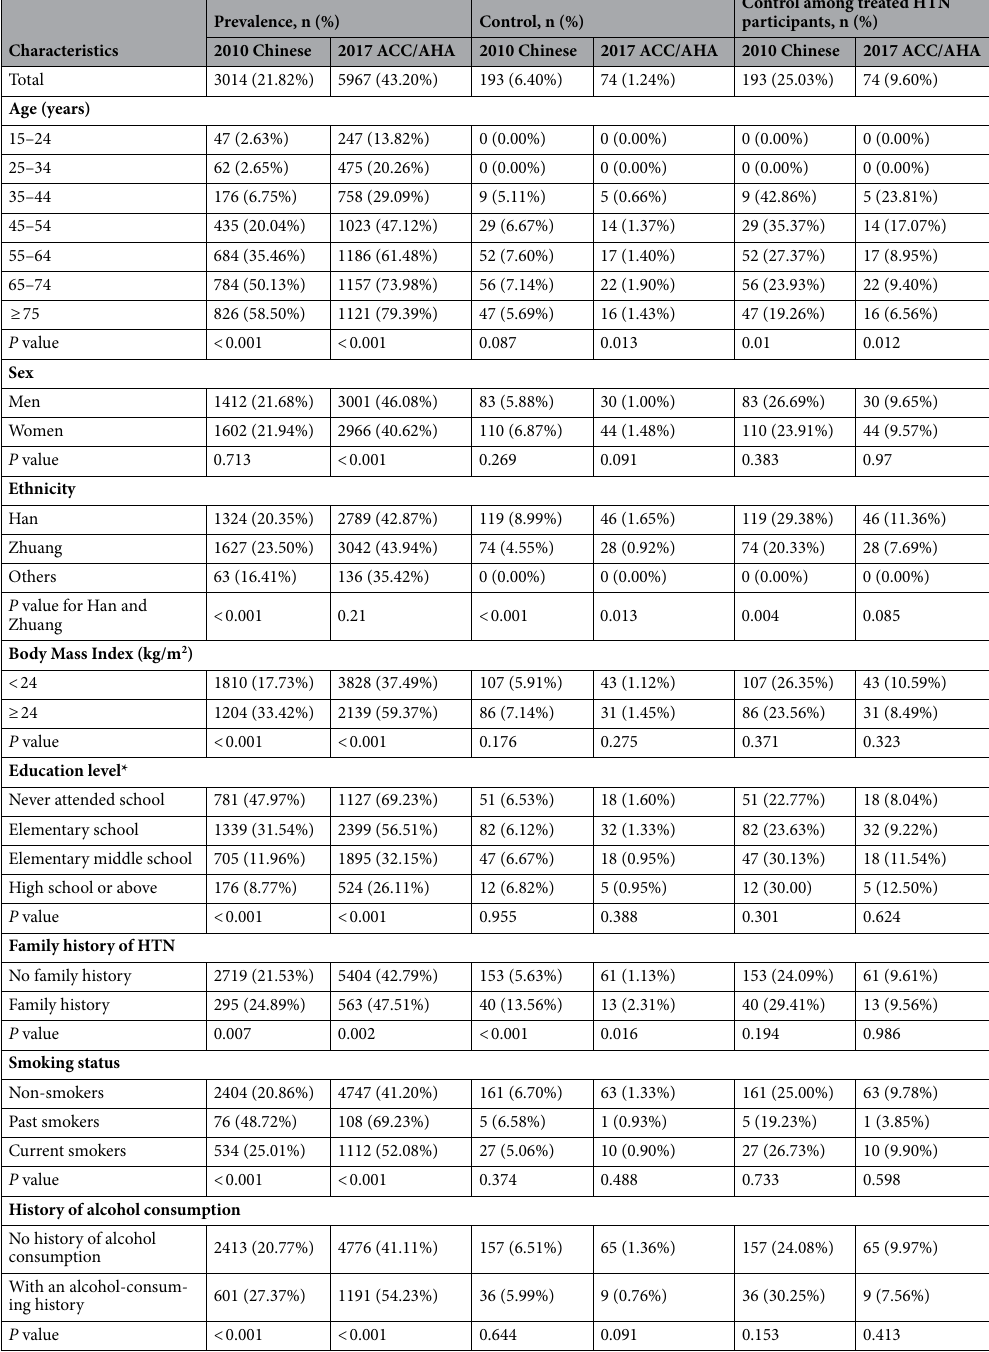
Table 4. Prevalence and control rate of HTN based on 2010 Chinese high blood pressure guideline and 2017 ACC/AHA high blood pressure guideline. HTN Hypertension, BMI Body Mass Index. Data are presented as n (%). *Missing 38